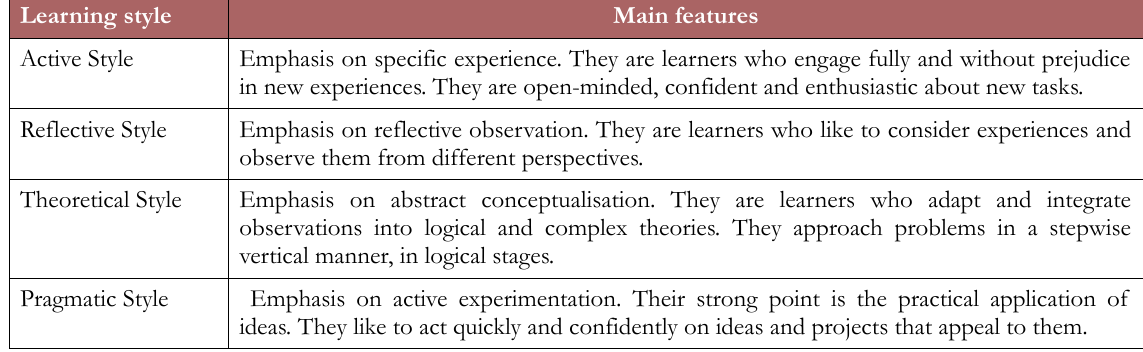
Table 1. Characteristics according to learning